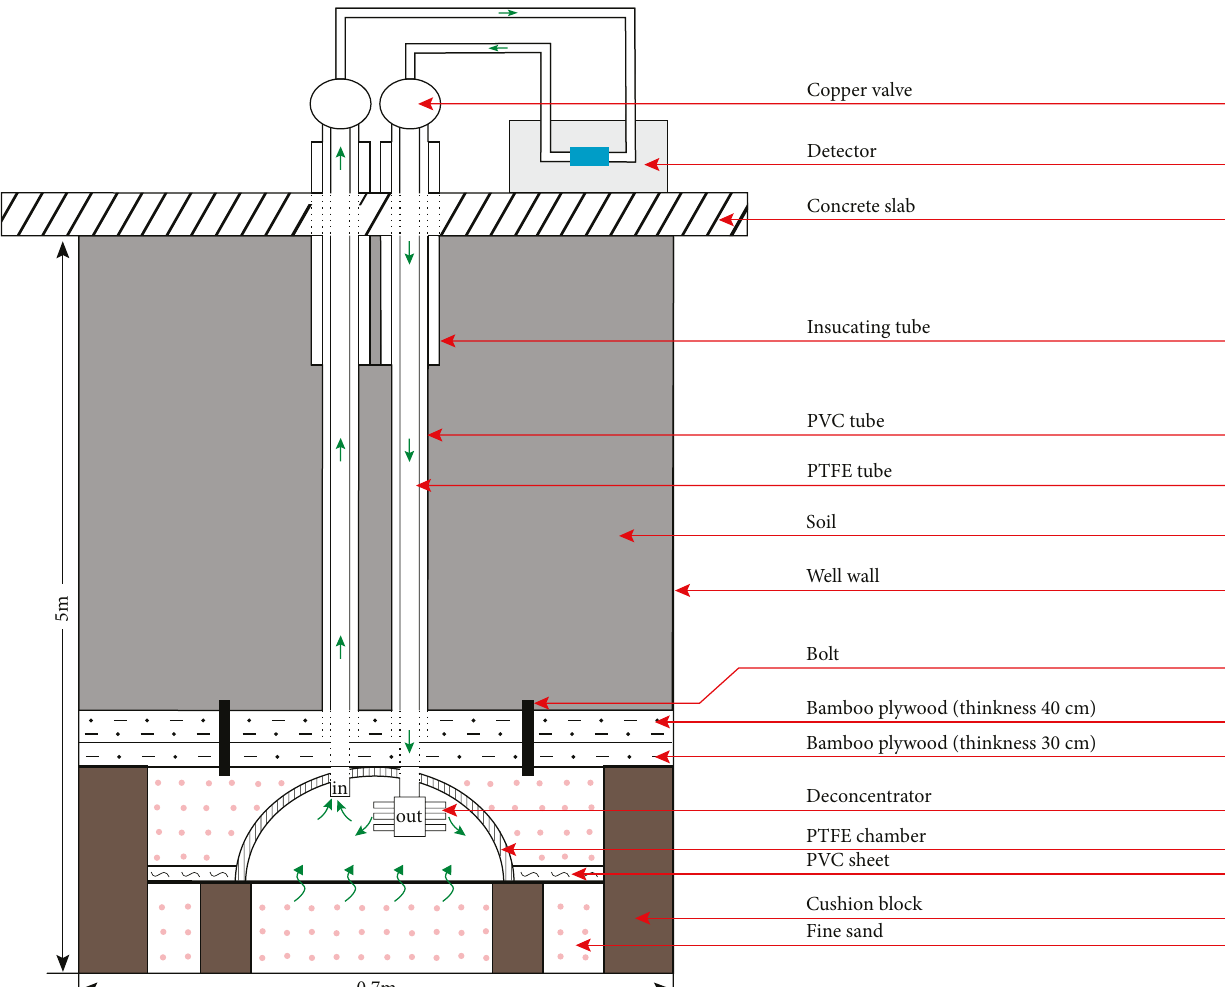
Figure 3: A sketch of the constructed soil gas well.